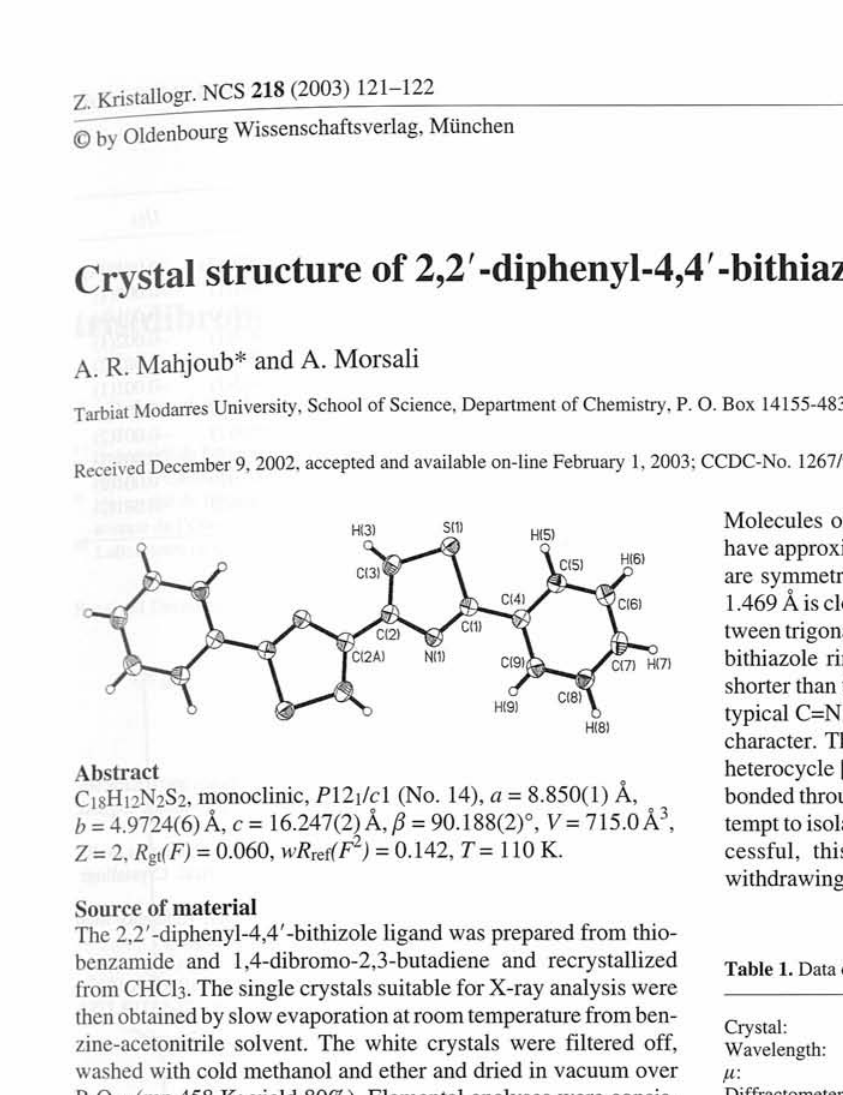
Table 1. Data collection and handling.